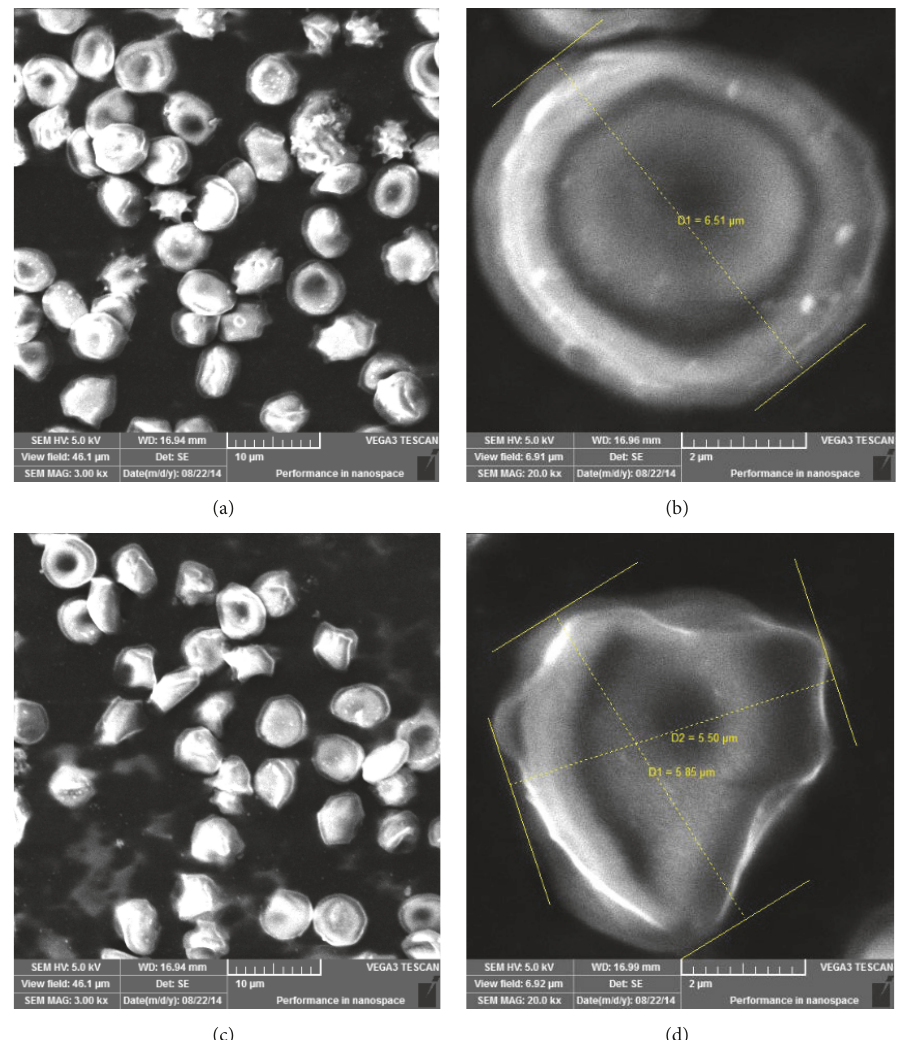
Figure 2: Morphology of erythrocytes after experimental procedure. (a) Sb-EtOH + H 2 O 2 (10 𝜇 m); (b) Sb-EtOH + H 2 O 2 (2 𝜇 m); (c) NaCl 0.9% + H 2 O 2 (10 𝜇 m); (d) NaCl 0.9% + H 2 O 2 (2 𝜇 m). Figures are obtained by scanning electron microscopy.